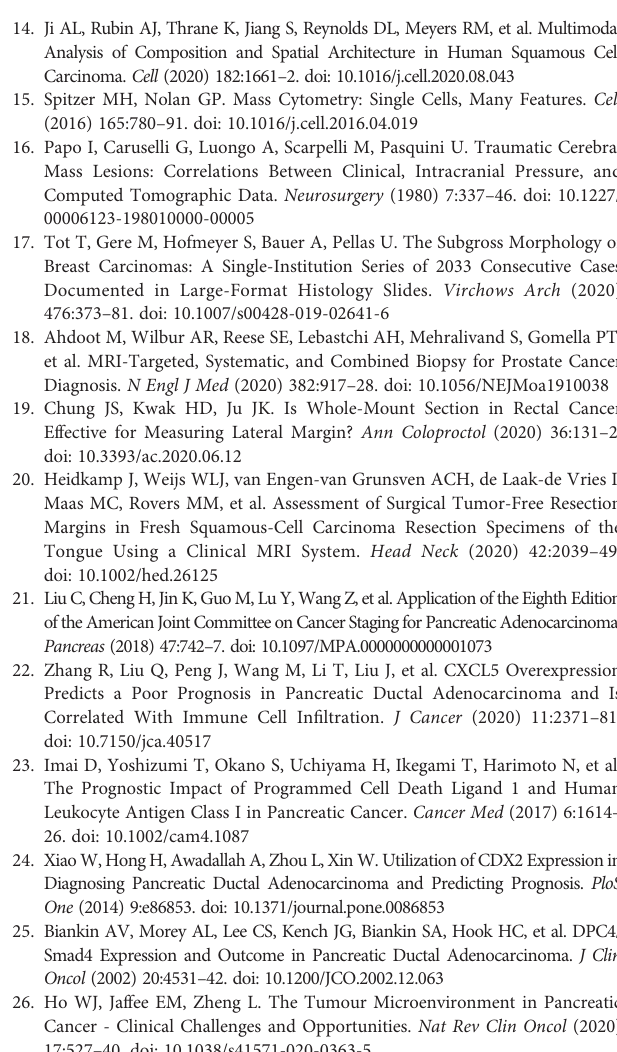
Supplementary Figure 1 | Panoramic scanning images of CD4, CD8, CD15, CD20 and CD56 in LSH of PDAC after immunohistochemical staining. LSH, large- section histopathology; PDAC, pancreatic ductal adenocarcinoma. Supplementary Figure 2 | Panoramic scanning images of CD4, CD8, CD15, CD20 and CD56 in SSH of PDAC after immunohistochemical staining. SSH, small- section histopathology; PDAC, pancreatic ductal adenocarcinoma. Supplementary Figure 3 | H&E images for LSH and SSH and H&E panoramic scan of LSH in PDAC. LSH, large-section histopathology; SSH, small-section histopathology; PDAC, pancreatic ductal adenocarcinoma. Supplementary Figure 4 | Kaplan-Meier survival analysis curves according to 14 (A – N) variables that were associated with PDAC prognosis. PDAC, pancreatic ductal